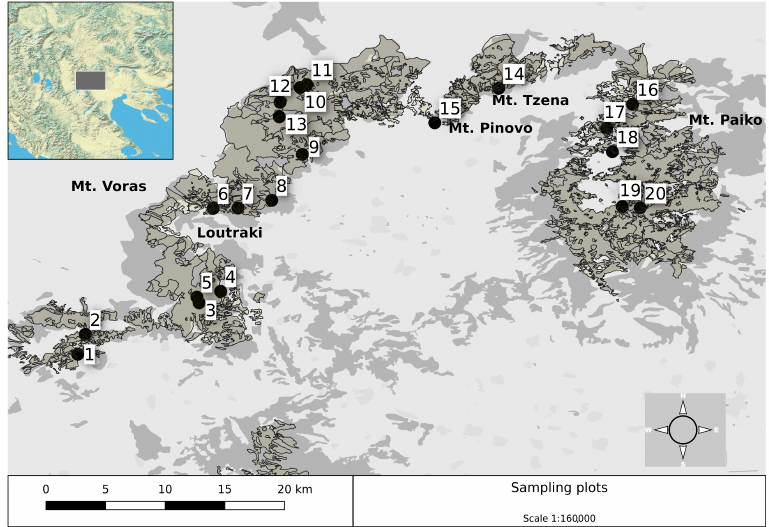
Figure 1. Map of the Almopia basin with the 20 sampling plots of this study. Light-gray shading shows mountains and dark-gray shading the expansion of beech.